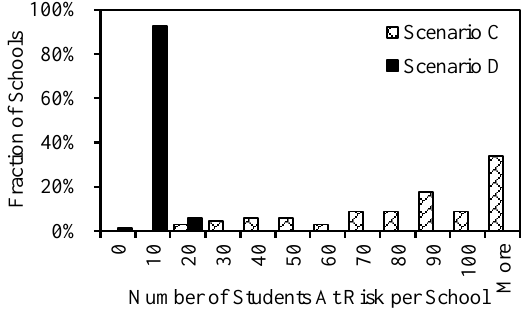
Figure 6. Distribution of at-risk population for secondary schools.